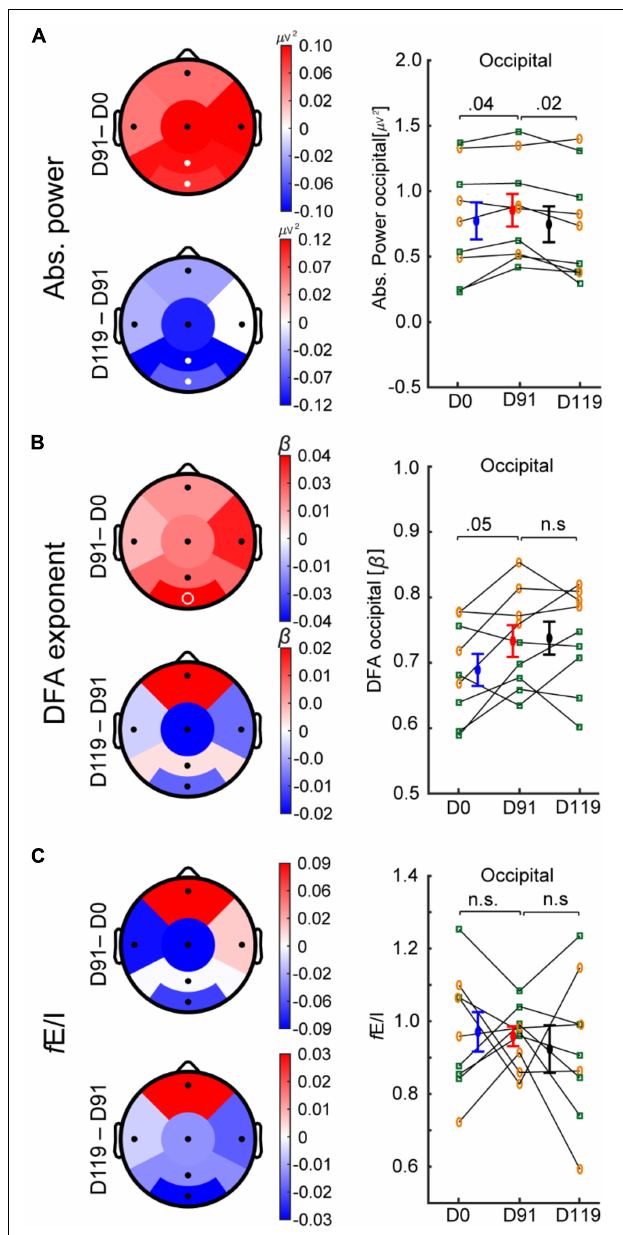
FIGURE 3 | Bumetanide treatment increases the power of alpha oscillations in TSC. Treatment effects on EEG measures in six regions (D91-minus-D0 and D119-minus-D91) for absolute power, DFA, and f E/I are shown. (A) After 91 days of bumetanide treatment, absolute power increased in parietal and occipital regions, which returned to baseline after the washout period. (B) DFA increased in the occipital region, but did not reach significance. (C) f E/I mean values were not different between time points. Bumetanide appeared to reduce the f E/I variance in occipital region (Bartlett test of variance p = 0.06), which increased after the washout period (Bartlett p = 0.02). White filled circles represent significant regions (paired t -test, p -value < 0.05, FDR corrected), white unfilled circles indicate p < 0.05 without FDR correction. Individual values, mean, and SEM are plotted per time point for the occipital region (A–C) . Concomitant treatment with antiepileptic drug ( yellow circles ) or not ( green squares ). D0, day-zero baseline recording; D91, day 91 of treatment; D119, day 119 (after 28-days of washout